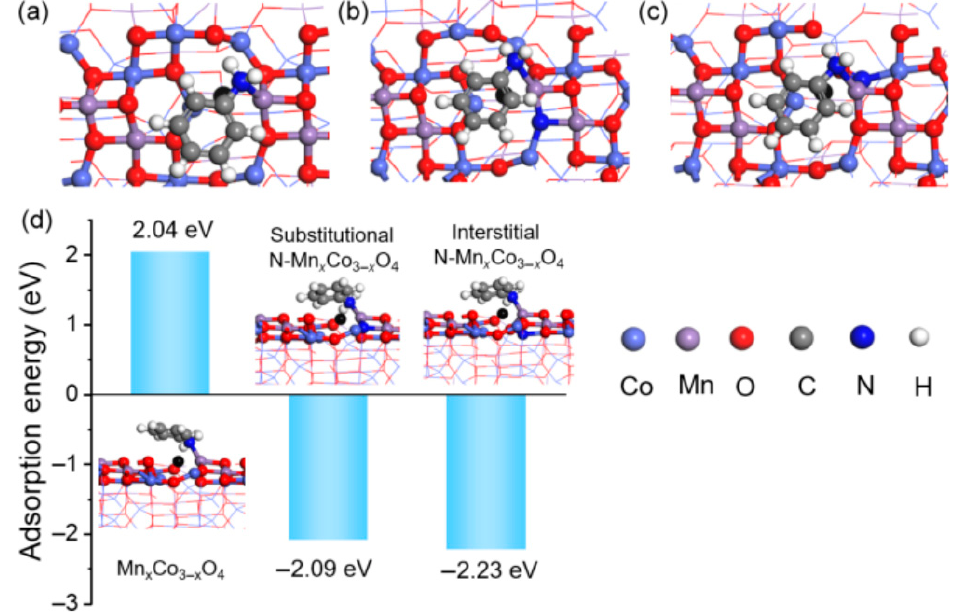
Figure 2. ( a – c ) the chemical structure of Mn x Co 3 − x O 4 , interstitial N-Mn x Co 3 − x O 4 , and substitutional N-Mn x Co 3 − x O 4 , ( d ) the DFT calculation of adsorption energy of aniline on the surface of Mn x Co 3 − x O 4 , interstitial N- Mn x Co 3 − x O 4 , and substitutional N- Mn x Co 3 − x O 4 [39]. (Reproduced from Ref. [39] with permission from the